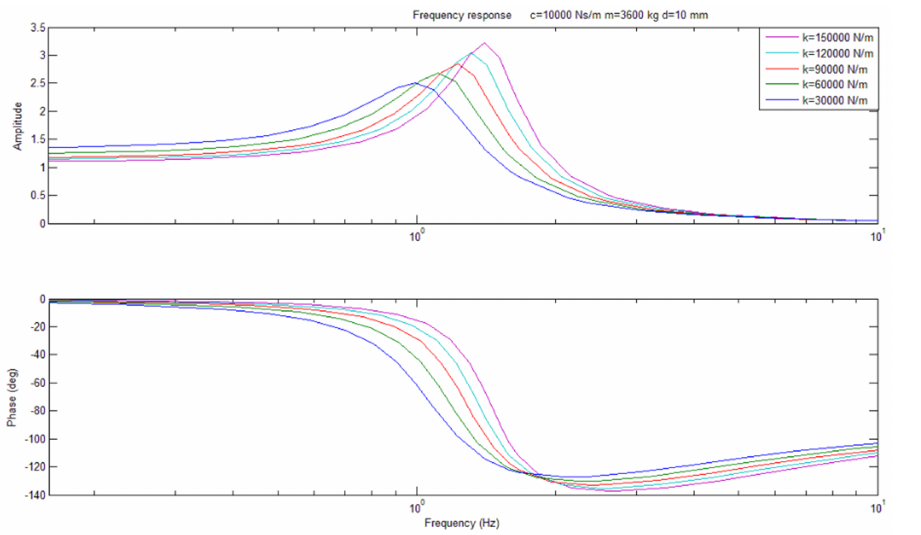
Figure 3 – Transfer function of vertical displacement for different values of spring stiffness Slika 4 – Prenosna funkcijavertikalnogpomeranjazarazli č